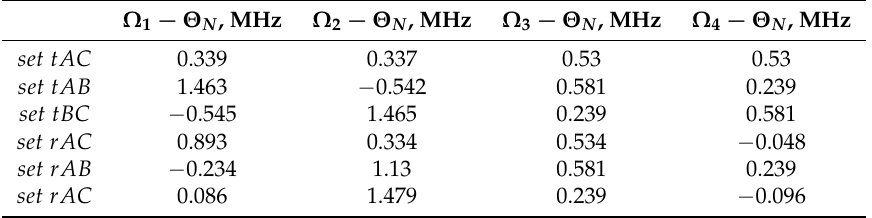
Table 2. Example sets for tuning the routing of the six-port